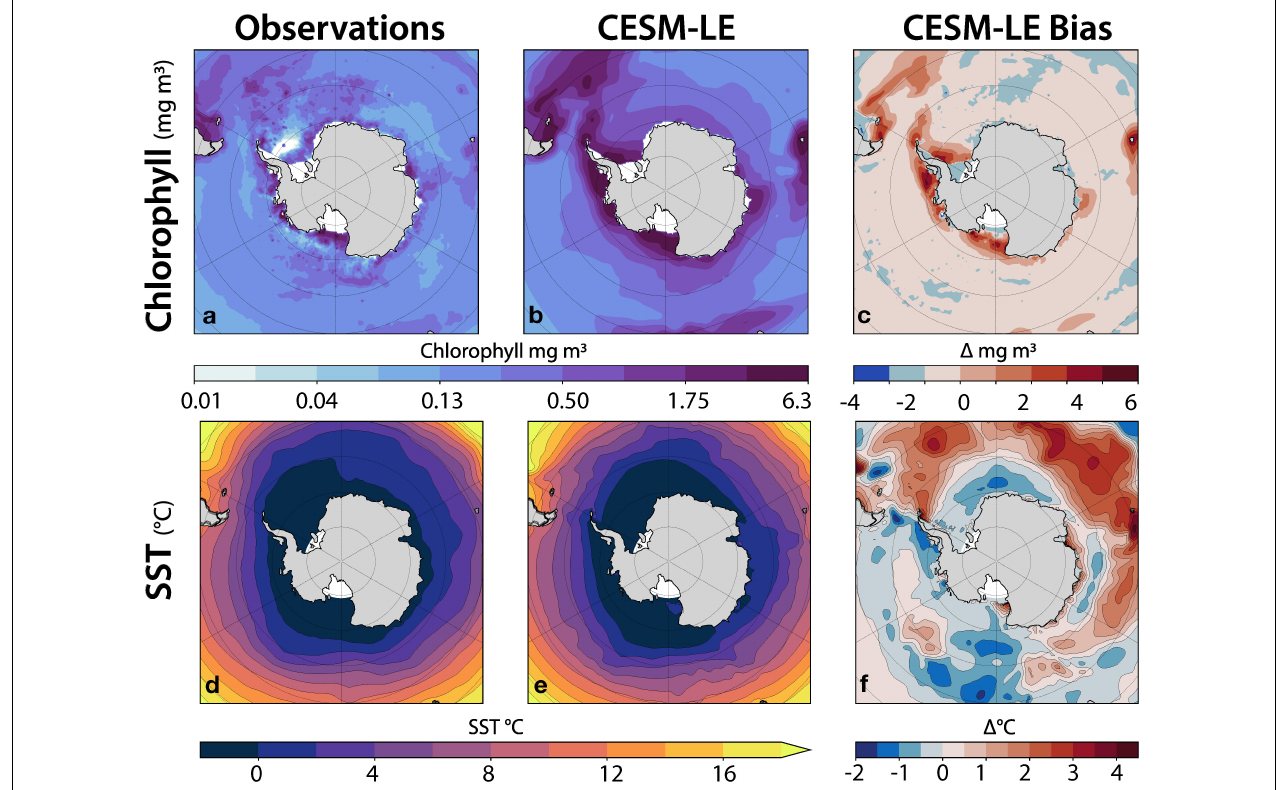
FIGURE 2 | CESM-LE model bias in chlorophyll (top row) and SST (bottom row) for DJF (austral summer). The left column shows observations, the middle column shows the corresponding simulated CESM-LE fields, and the right column shows the simulated bias as the difference between the simulated fields and the